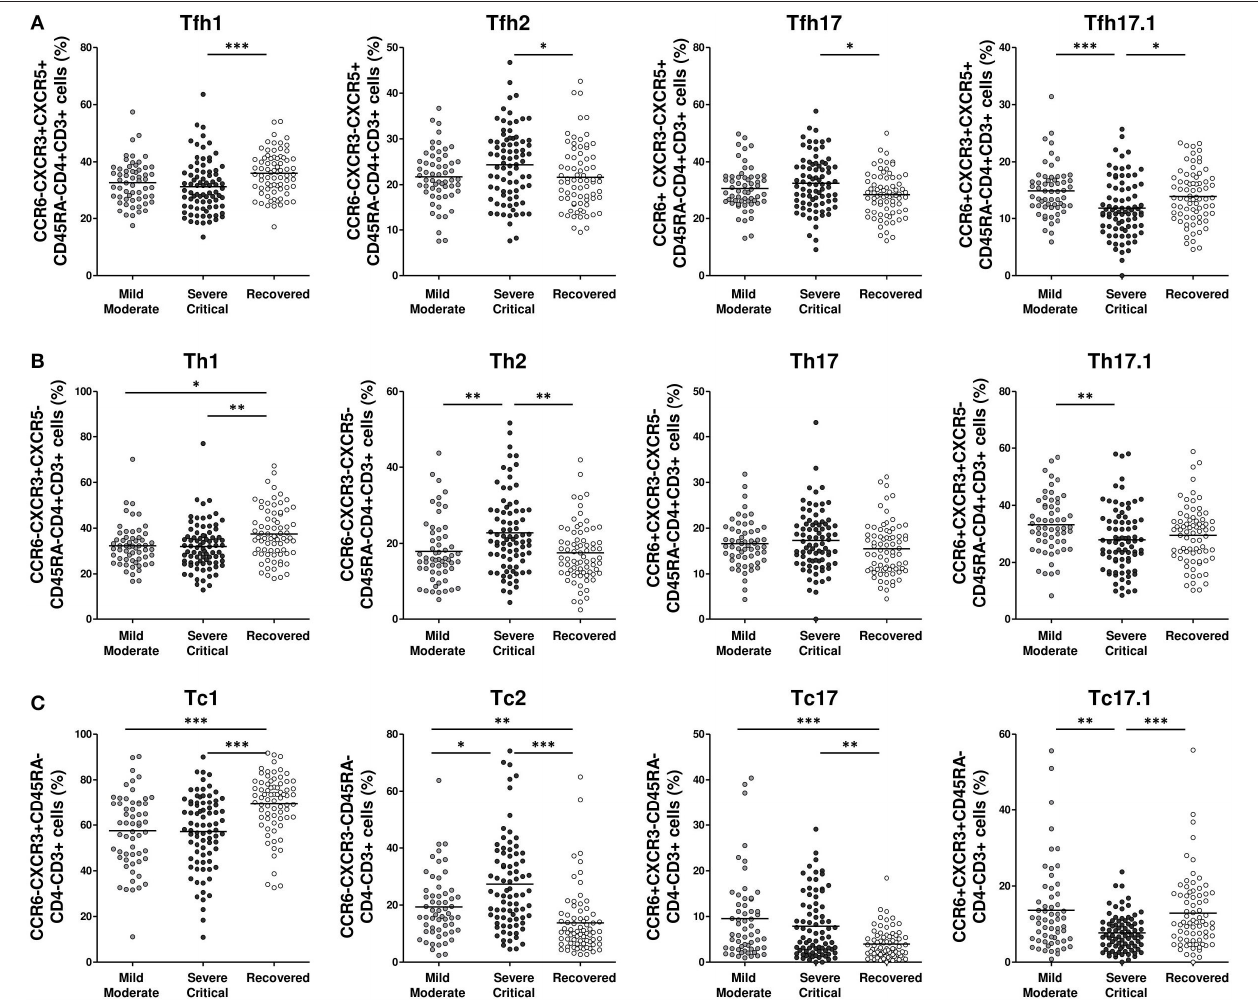
FIGURE 3 | Lower Tfhl, Thl, and Tel and higher Tfh2, Th2, and Tc2 cells frequency in severe/critical COVID-19 patients. Frequency of T follicular helper cells (A) , T helper cells (B) and T cytotoxic cells (C) in mild/moderate (light gray circles), severe/critical (dark gray circles) and recovered (white circles) groups of patients. Each dot represents an individual patient. Data are given as mean (Kruskal–Wallis test P- values: * P < 0.05; ** P < 0.01; *** P < 0.001). Tfh, T follicular helper; Th, T helper; Tc, T